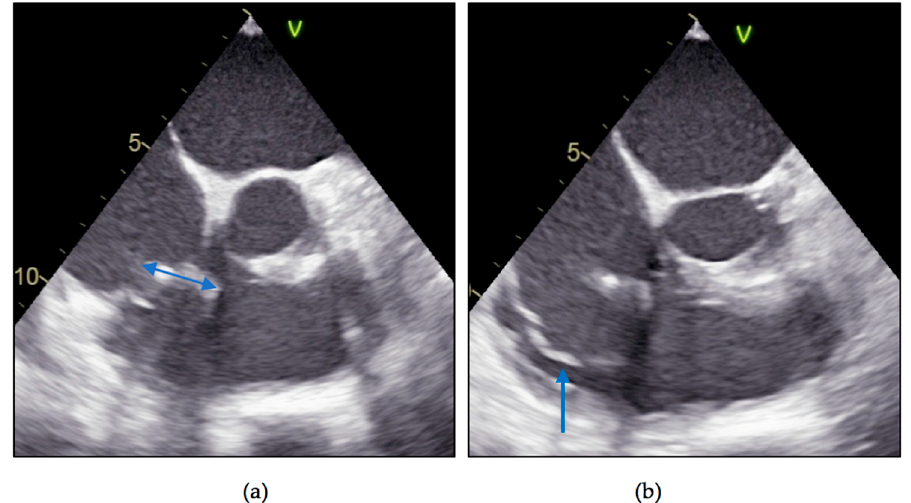
Figure 4. Transesophageal two-dimensional echocardiography: ( a ) pedunculated mobile mass (blue, double-headed arrow) attached to pacing lead (19/5 mm); ( b ) posterior leaflet of the tricuspid valve with hypermobility and rupture of chordae (blue arrow).